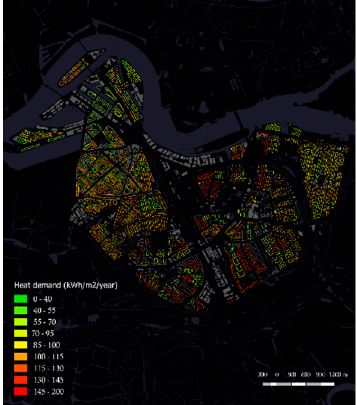
Figure 8. Heat demand map of Rotterdam Zuid in 2019.